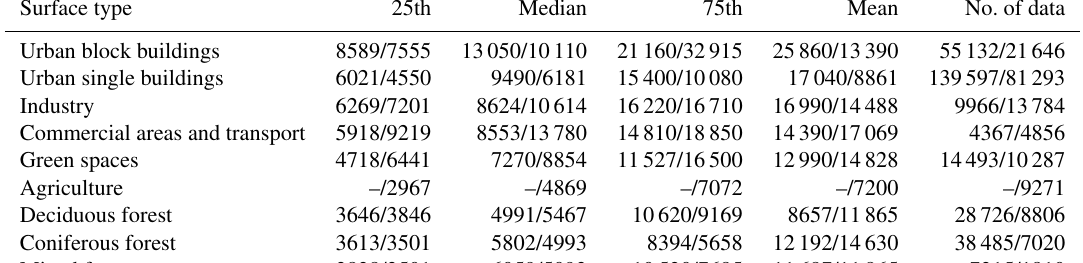
Table 6. Particle number concentrations (bicycle/van (background) measurements) for different land use types in particles per cubic cen- timeter. “–” indicates areas which have not been tested by the method. This table provides the 25th, 50th and 75th percentiles as well as the mean and the number of available data points.